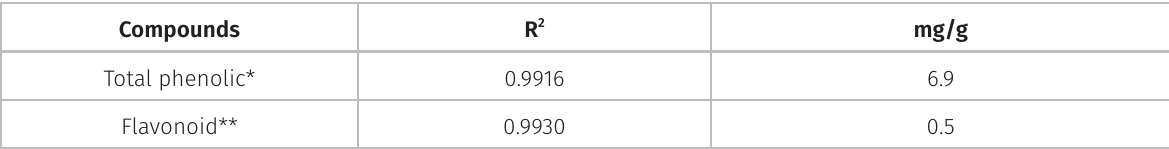
Table I. Concentration of phenolic compounds and flavonoid in the Ilex paraguariensis extract.